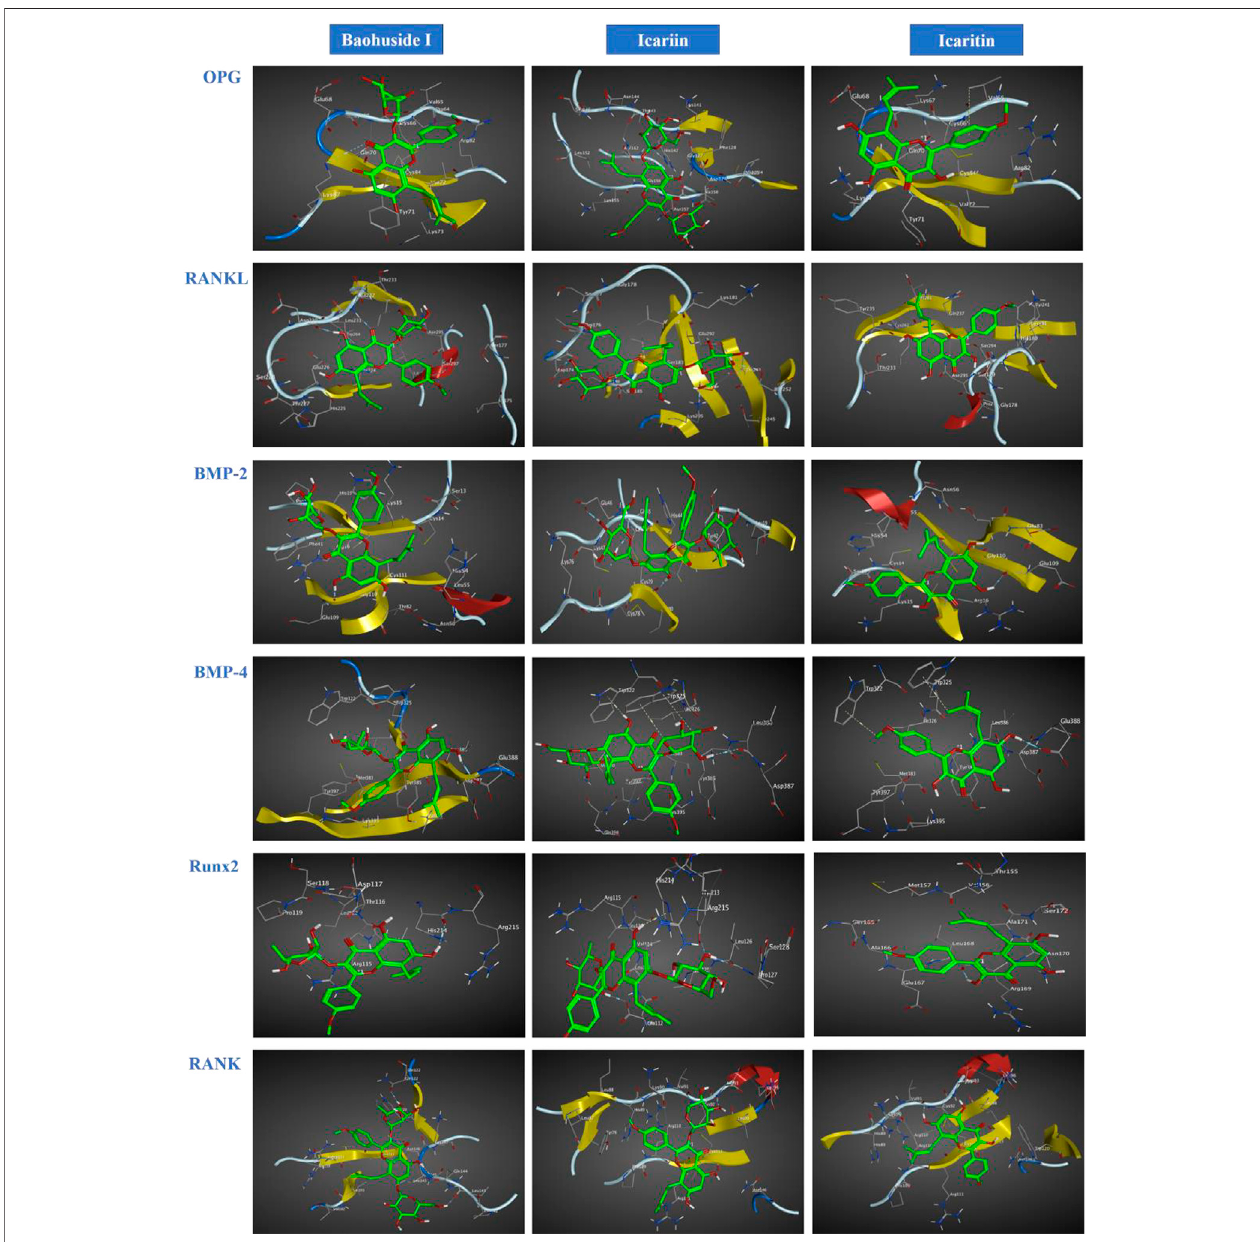
FIGURE 2 | Optimal interaction of the receptors with small molecule ligands. Receptors: OPG, RANKL, RANK, BMP-2, BMP-4, and RUNX-2; Ligands: BHG-I, ICA, IT.